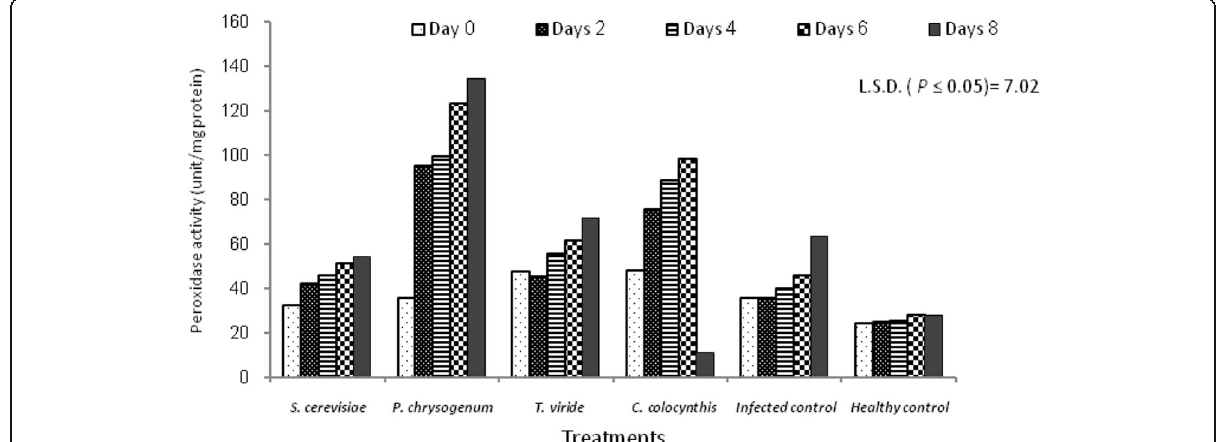
Fig. 3 Effect of application of bioagents and plant extract on peroxidase activity (PO) in onion plants